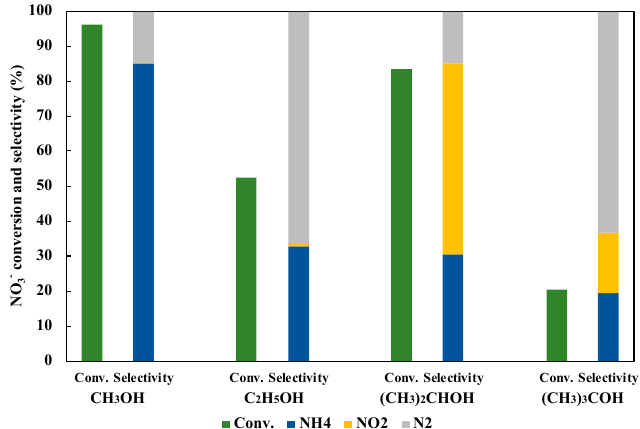
Figure 10. E ff ect of hole scavengers on NO 3 − reduction to NH 3 in 45 mL of 50 ppm NO 3 − aqueous solution including 10 vol% of hole scavenger under UV irradiation for three